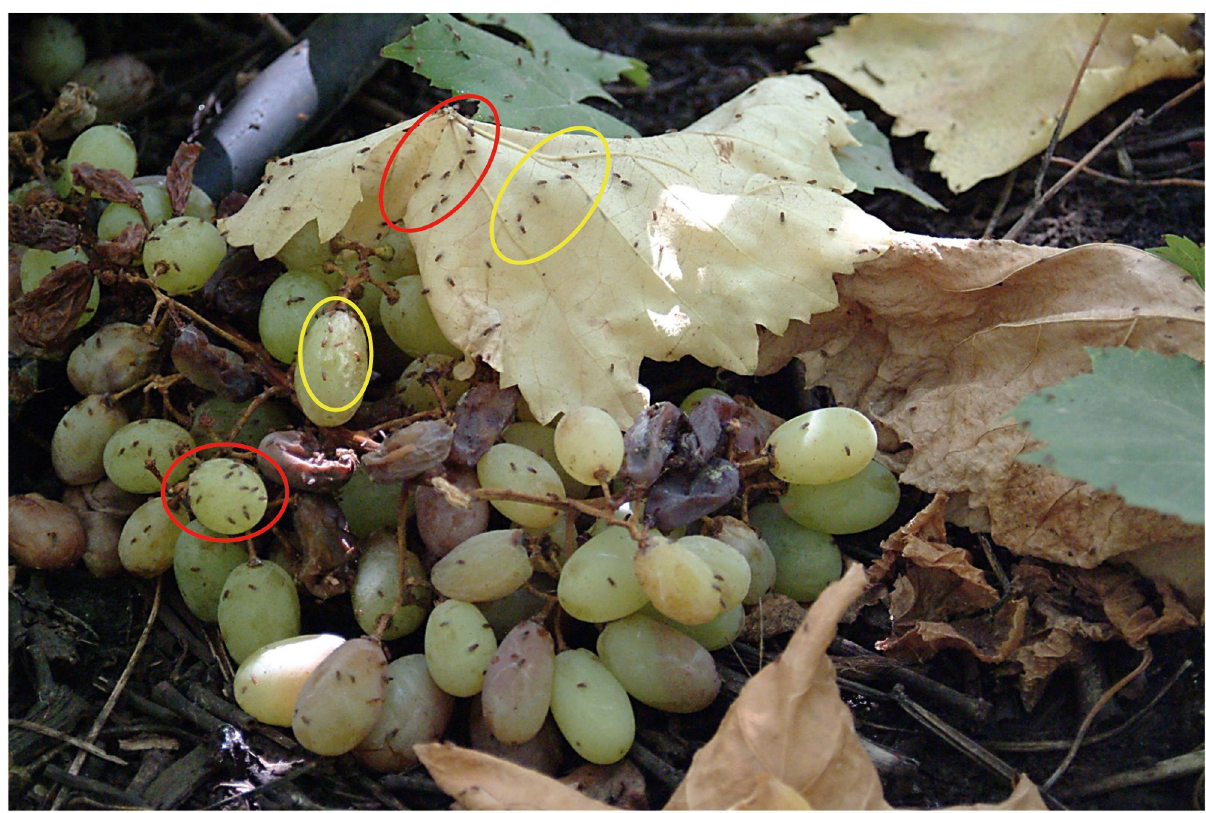
Fig 2. Non-random grouped distribution of adults of D . melanogaster and D . simulans on dry leaves and grape grains fallen on the ground. The orchard is in Fig 1. Adult flies of D . melanogaster are enclosed by a red oval; those of D . simulans are encircled by a yellow oval.